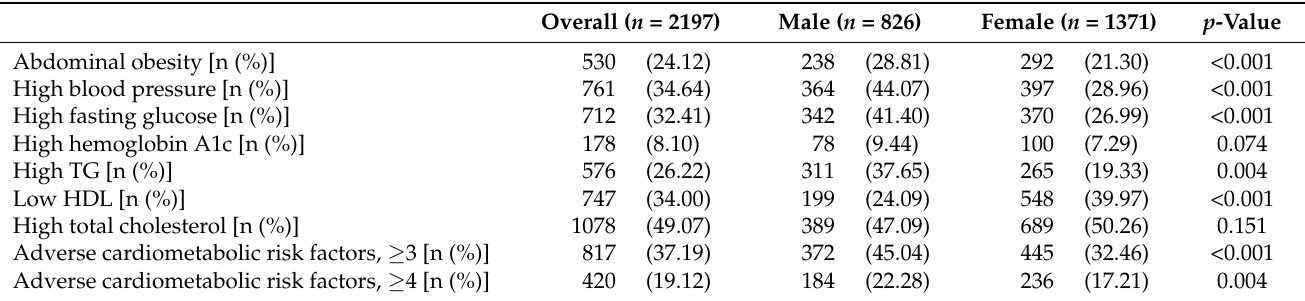
Table 2. Adverse cardiometabolic risk factors by